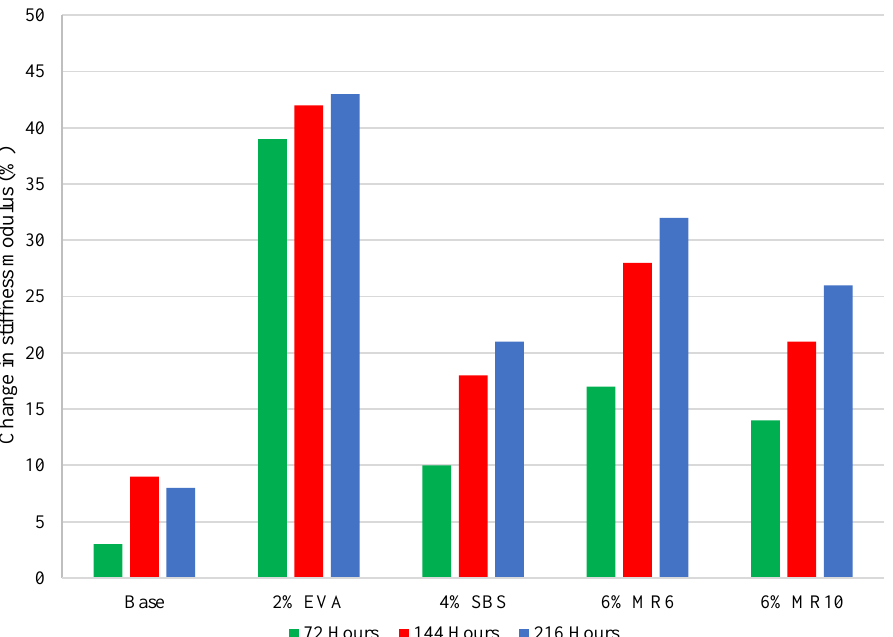
Figure 7. Average increase in mixture stiffness modulus after ageing cycles.